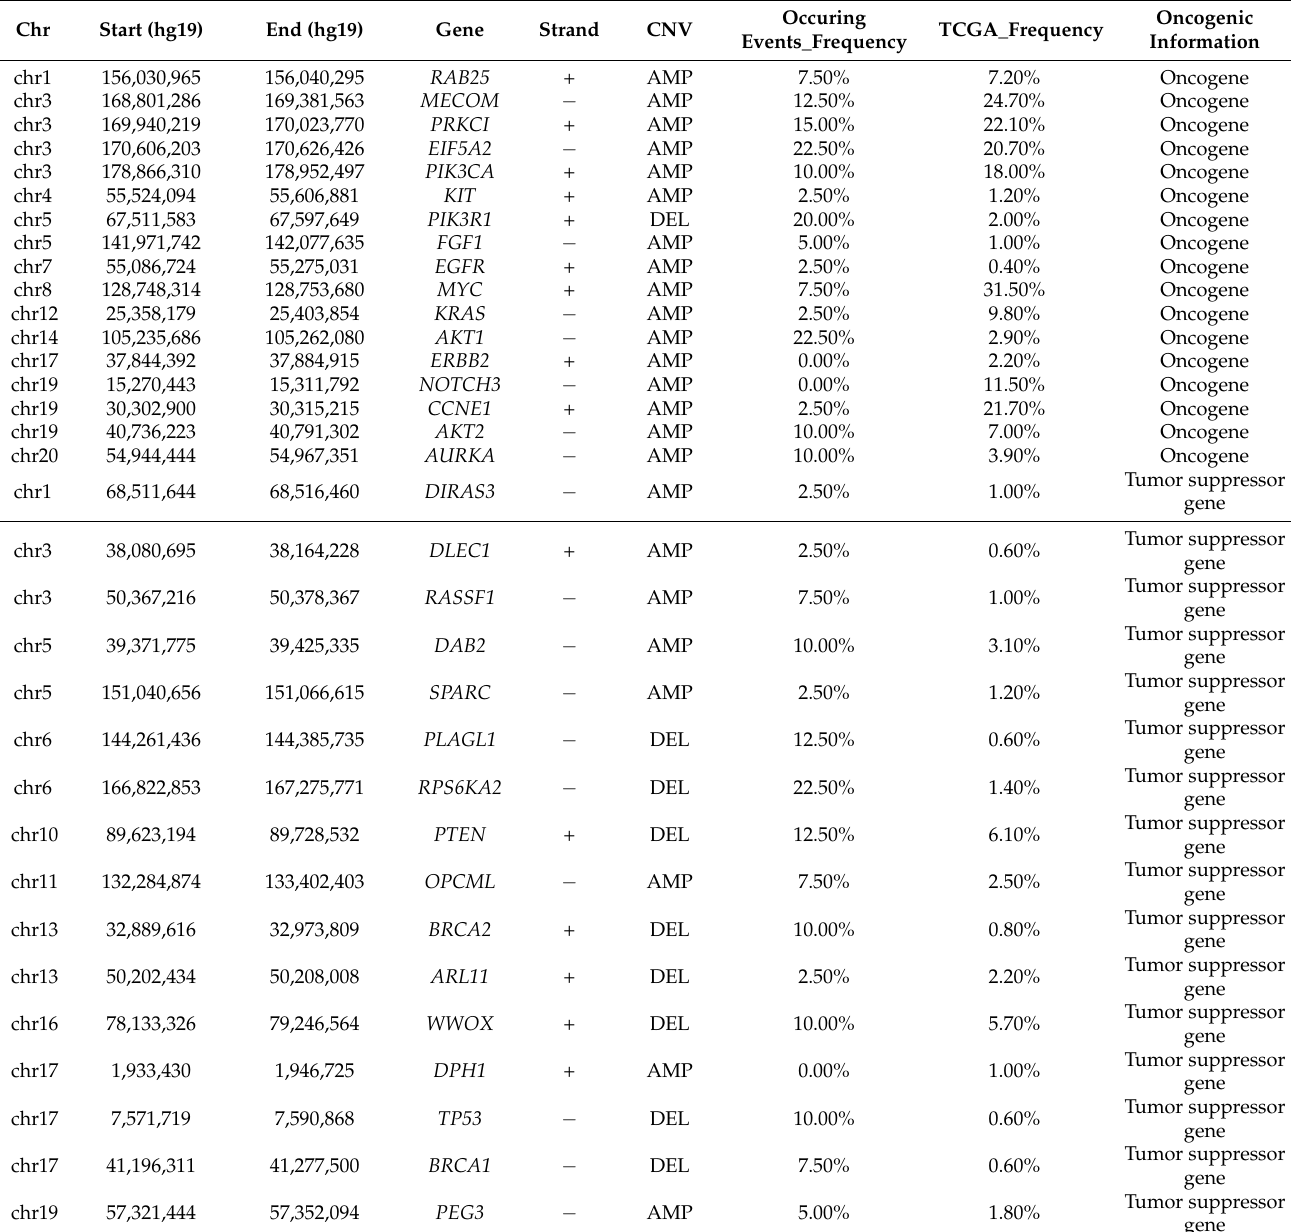
Table 2. Copy number variation (CNV) pattern of ovarian cancer-specific oncogenes and tumor suppressor genes from TCGA